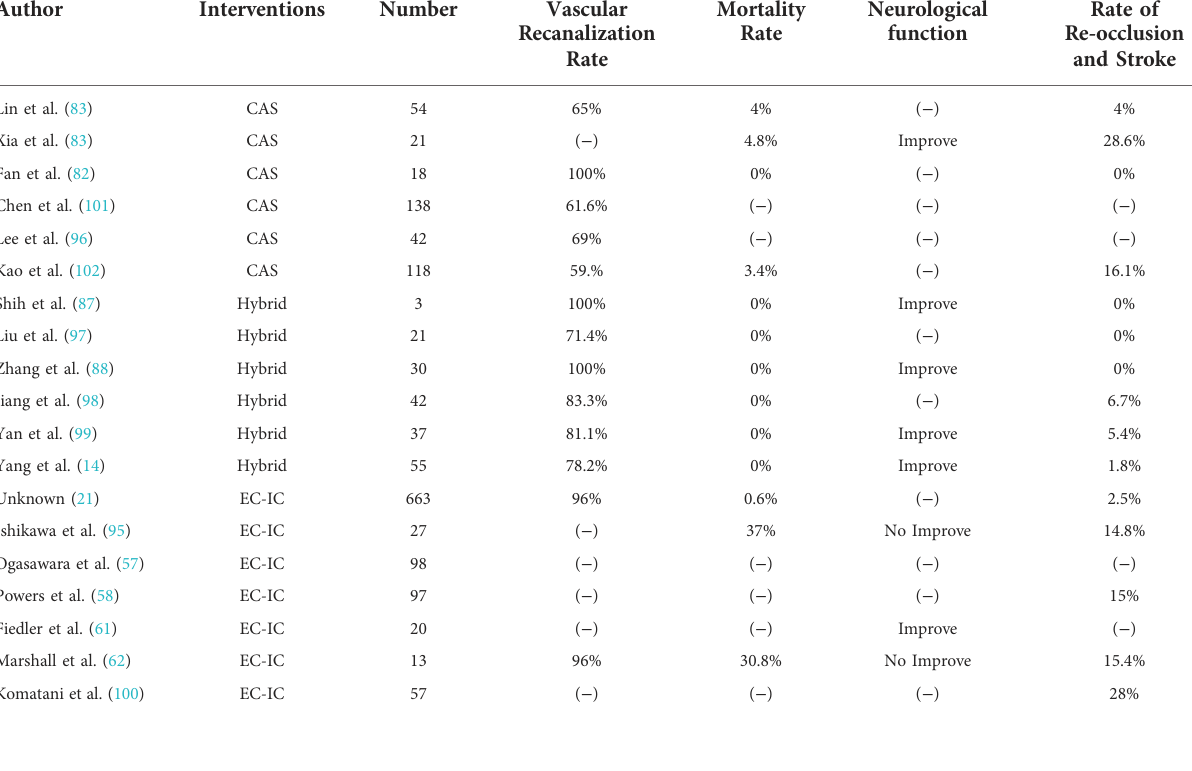
TABLE 2 Therapeutic effects and post-surgical complications of included